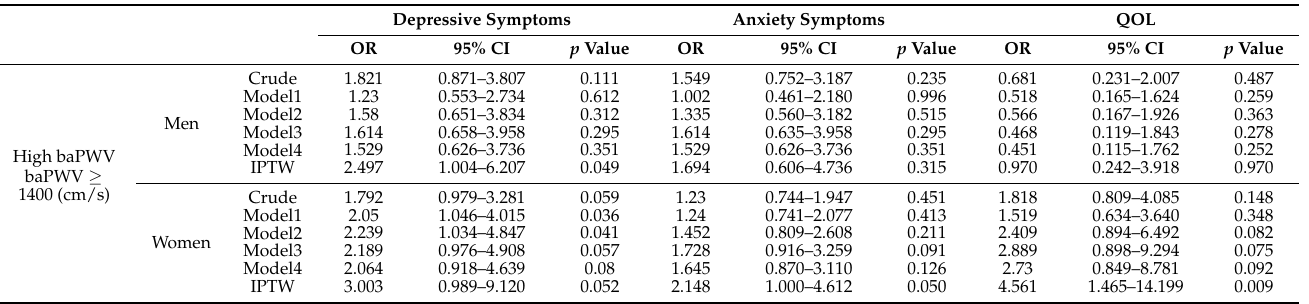
Table 4. Multivariable analysis to assess the association between baPWV and depressive and anxiety symptoms and quality of life according to sex. Depressive Symptoms Anxiety